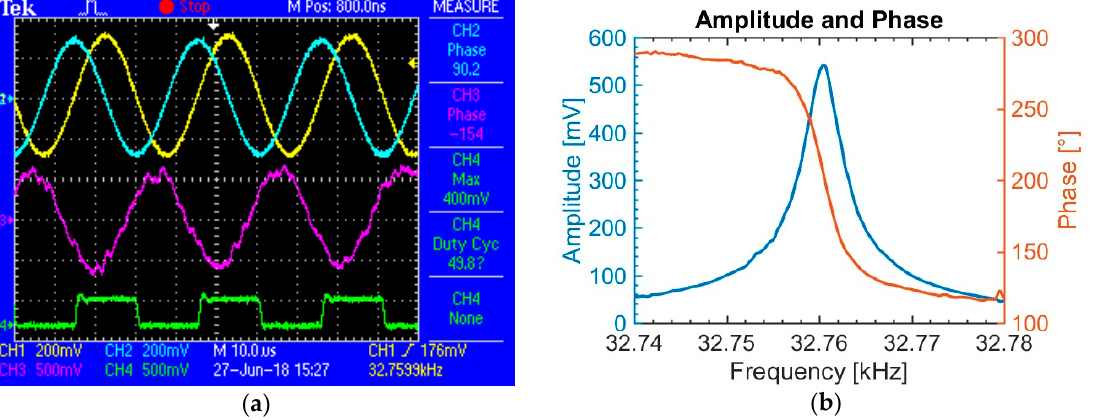
Figure 2. ( a ) Oscilloscope capture during test phase: yellow—sine wave (1st DDS), turquoise—cosine wave (2nd DDS), purple—measured signal, green—pulsed laser current; ( b ) MATLAB plot of amplitude and frequency of the QTF signal over frequency: blue—amplitude in mV, red—phase in